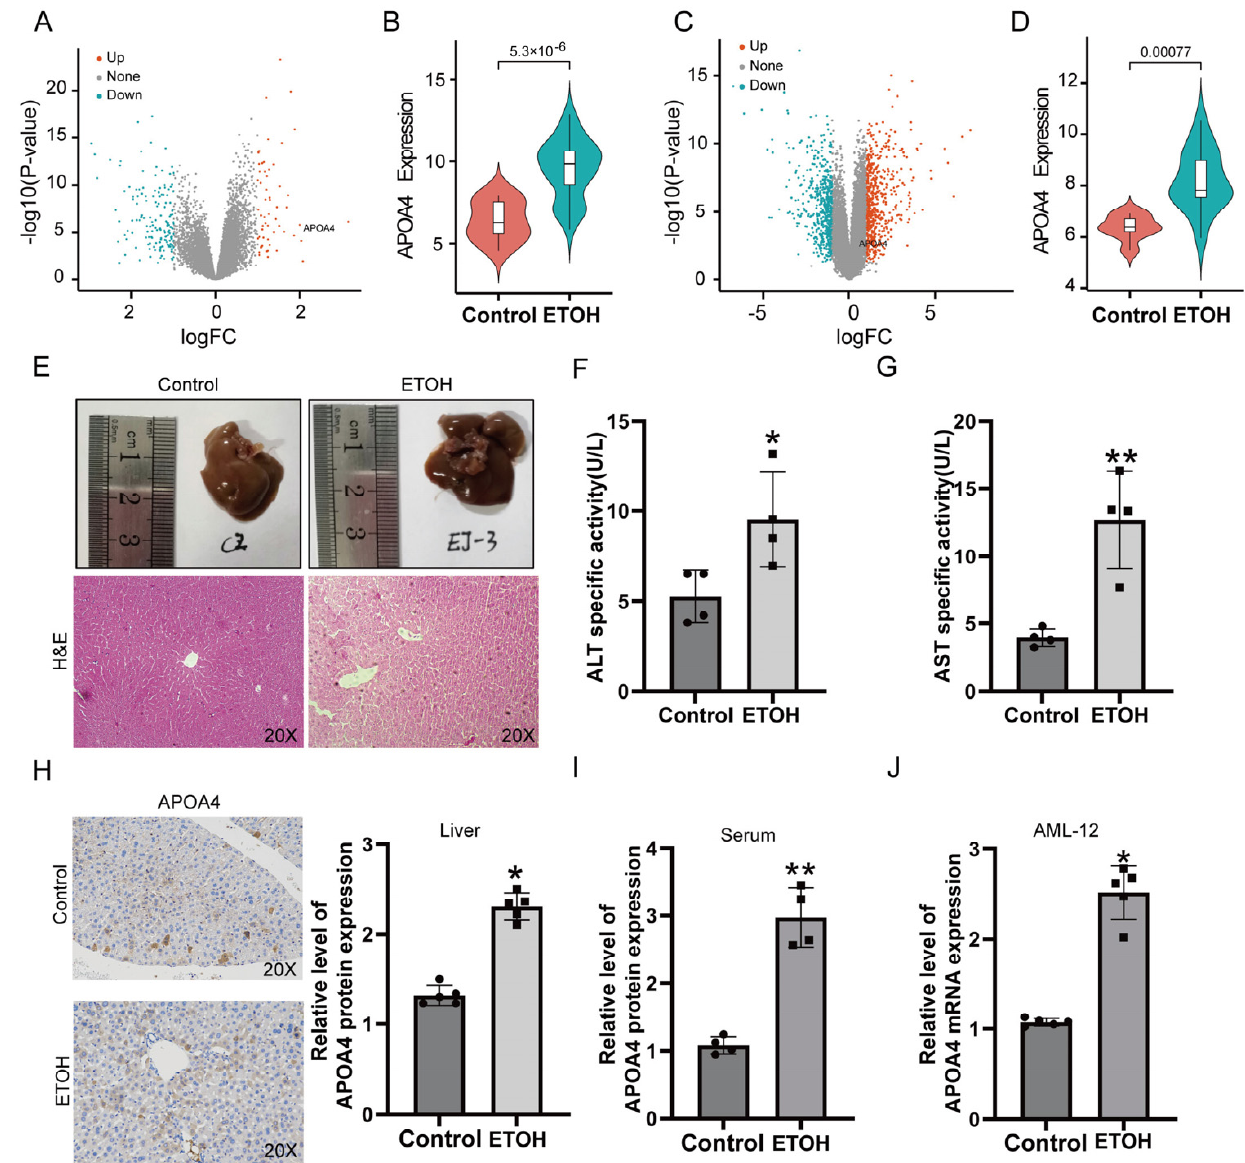
Figure 1. APOA4 is elevated in AH. Volcano plots showed the differentially expressed genes (DEGs) between AH and normal liver tissues in the E-MTAB-2664 dataset and the GSE28619 dataset. Orange dots indicate the up-regulated genes, blue dots indicate down-regulated genes, and gray dots indicate non-DEGs. ( A , B ) Volcano map and Box plot of APOA4 expression between AH and normal liver tissues in the E-MTAB-2664 dataset. ( C , D ) Volcano map and Box plot of APOA4 expression between AH and normal liver tissues in the GSE28619 dataset. ( E ) Hematoxylin-eosin (H&E) staining. ( F , G ) The activity of ALT and AST. ( H , I ) The expression of APOA4 in AH tissue as well as serum. ( J ) The expression of APOA4 in AML-12 cells after 200 µ mol/L ETOH treatment for 12 h. ( n = 3–6) * p < 0.05, ** p < 0.01 vs. the control group.